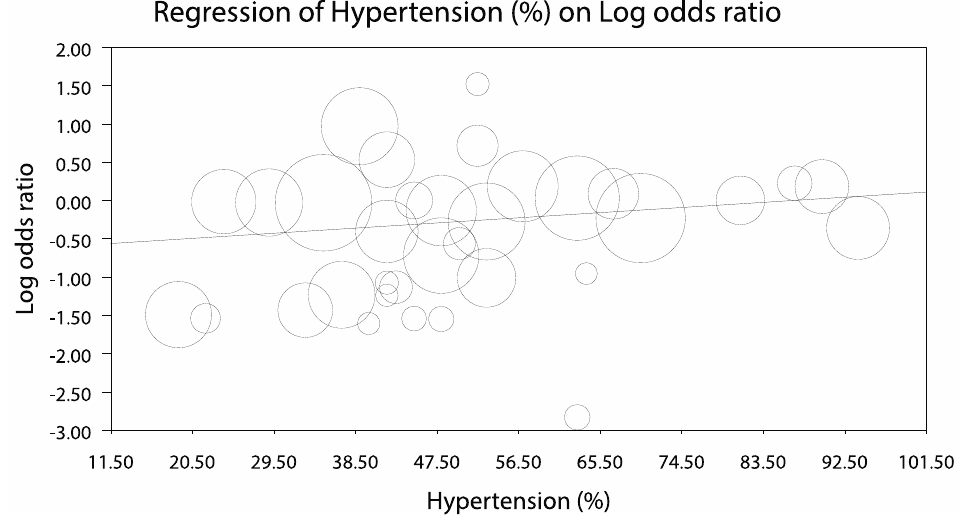
Figure A5. Meta-regression showing the impact of hypertension distribution on Log odds ratio.